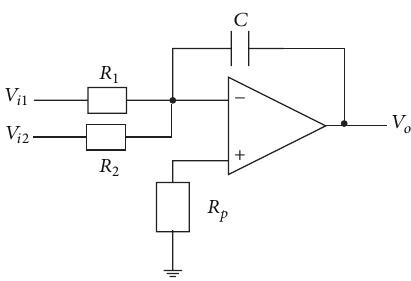
Figure 1: The summing inverting